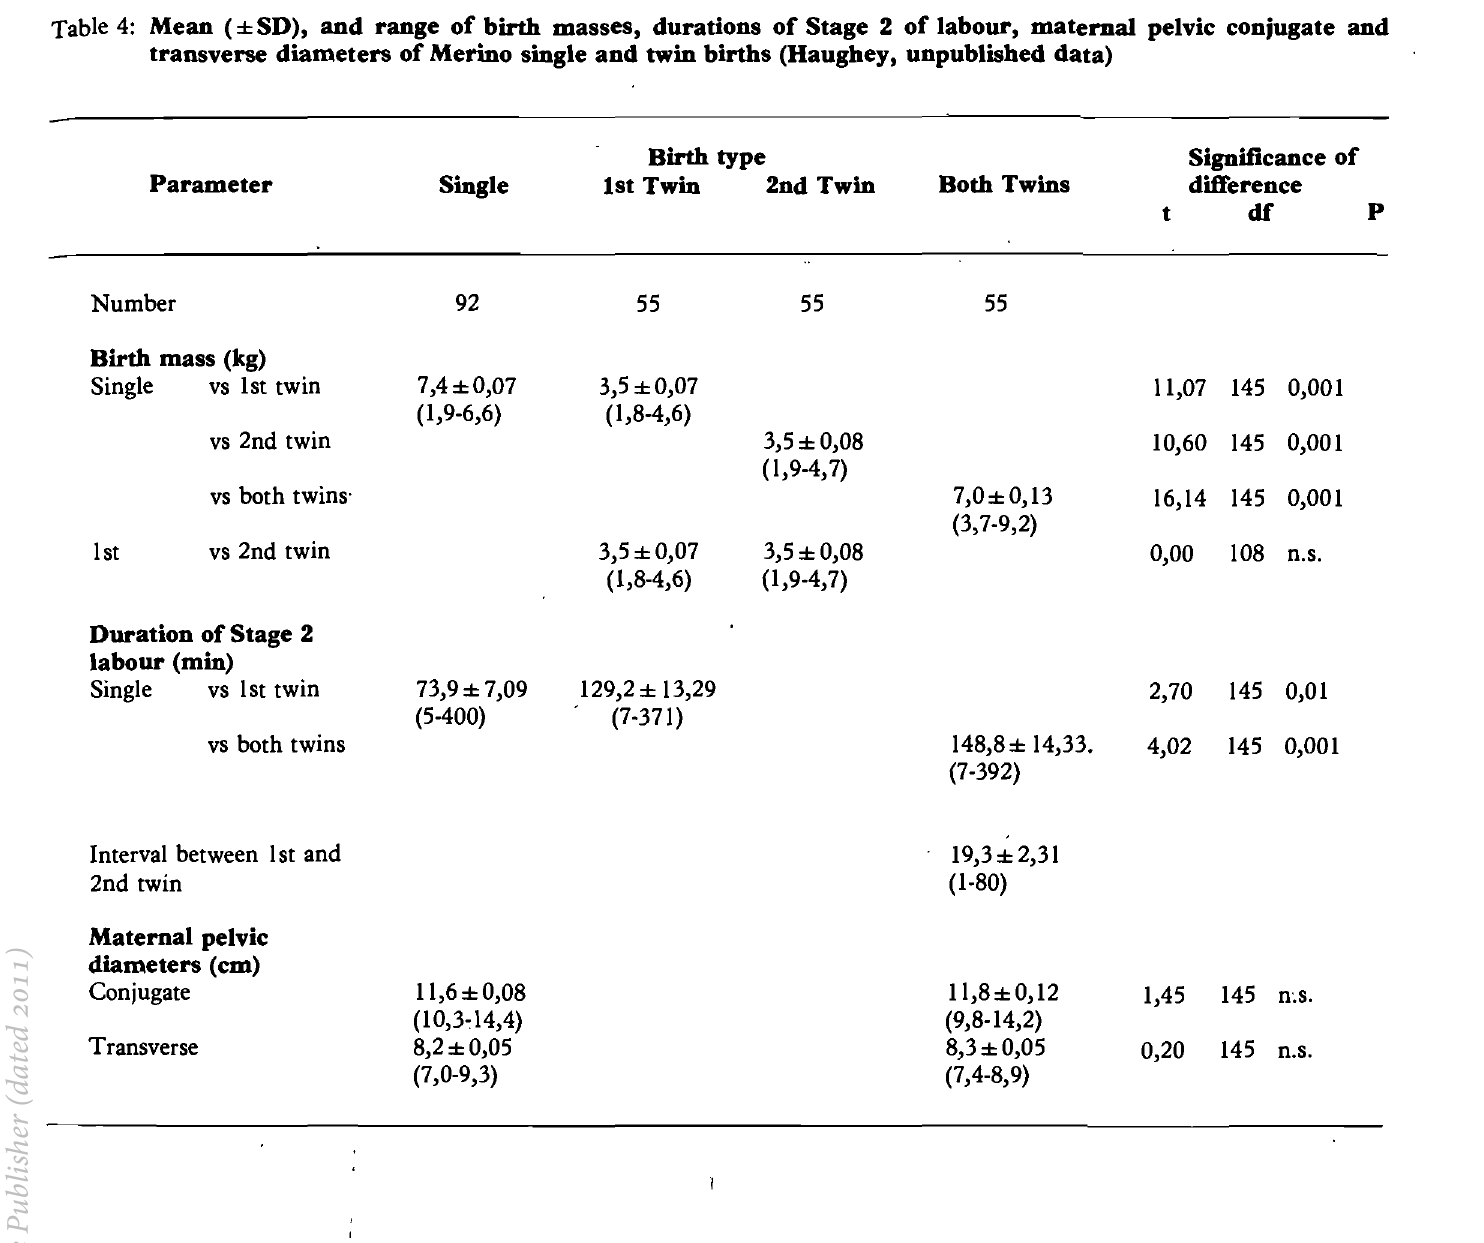
Table 4: Mean (±SD), and range of birth masses, durations of Stage 2 of labour, maternal pelvic conjugate and transverse diameters of Merino single and twin births (Haughey, unpublished